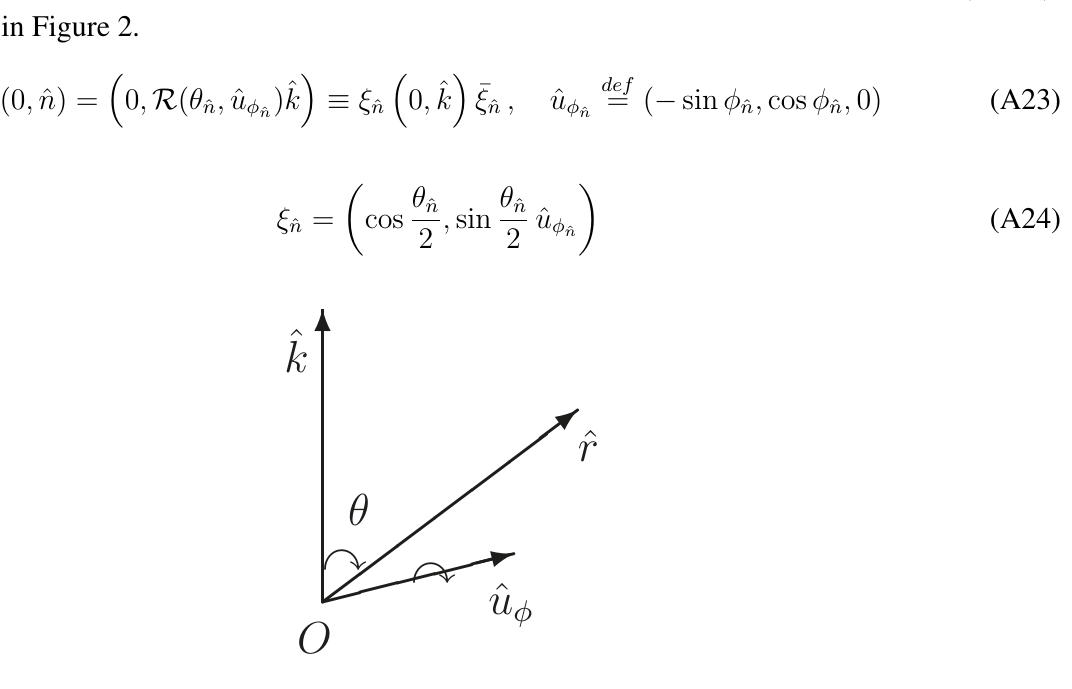
Figure 2. Rotation R mapping the unit vector pointing to the North Pole, ˆ k = (0 , 0 , 1) , to ˆ r . ˆ r Conflicts of